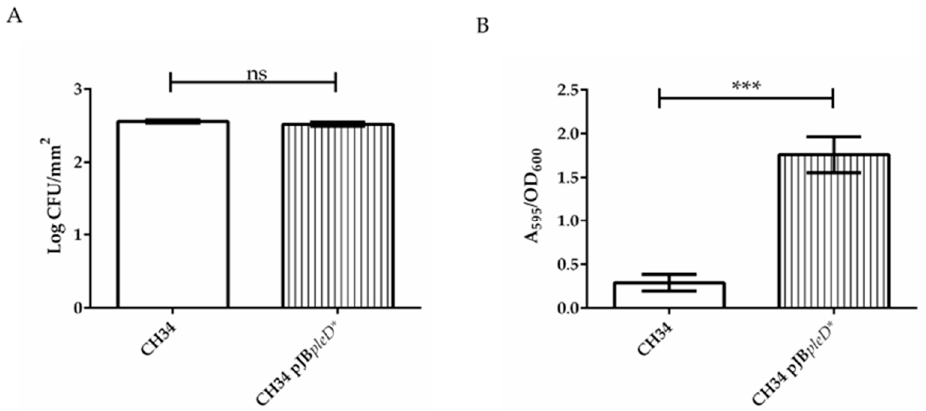
Figure 1. C. metallidurans CH34 pJB pleD * increased biofilm formation compared with wild-type strain CH34. Cell densities and biomass adherence in the biofilms of C. metallidurans strains CH34 and CH34 pJB pleD *. ( A ) Cell densities on biofilm surfaces. ( B ) Biomass adherence on surfaces. Data collected after 24 h incubation at 30 ◦ C. Values correspond with averages ± SD from three independent assays. Significant differences assessed by t -test: ns, non-significant; ***, p < 0.001.